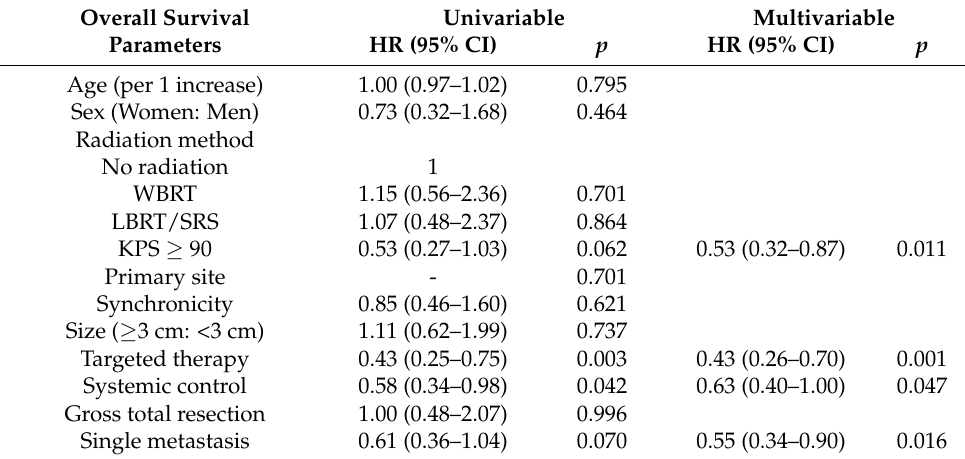
Table 2. Univariable and multivariable Cox regression for overall survival.